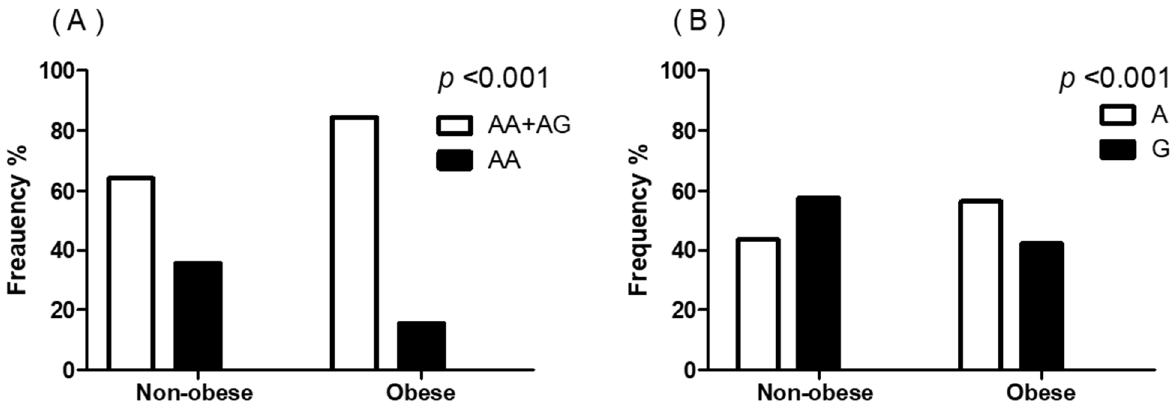
Figure 1. Frequency of RANTES genotypes and alleles according to the presence of obesity. ( A ) Distribution of genotypes of RANTES gene. ( B ) Frequency of alleles of RANTES gene. The p -values were calculated using the chi-squared test.